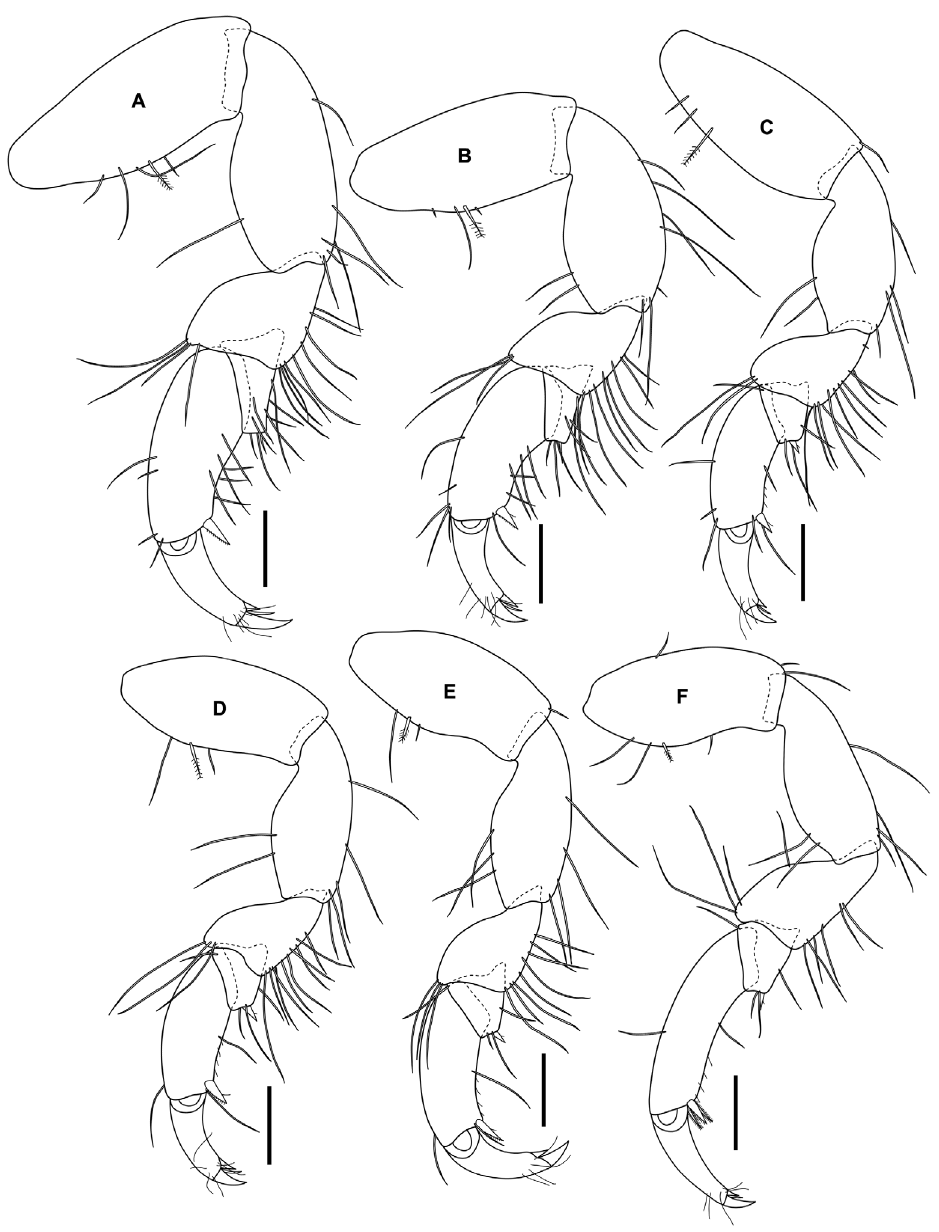
Figure 5. Tinggianthuraalba sp. n., holotype, female, (UKMMZ-1479). All scales represent 0.1 mm. (A) pereopod 2, (B) pereopod 3, (C) pereopod 4, (D) pereopod 5, (E) pereopod 6, (F) pereopod